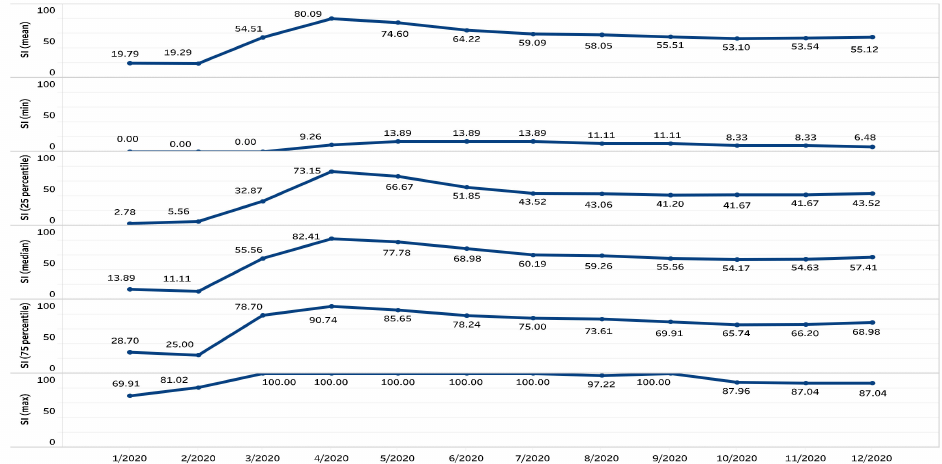
Figure 2. Variation in stringency index in 2020. Notes: I use policy stringency data from Oxford COVID-19 Government Response Tracker. Vertical axes show mean, minimum, 25 percentile, median, 75 percentile, and maximum of stringency index by month.